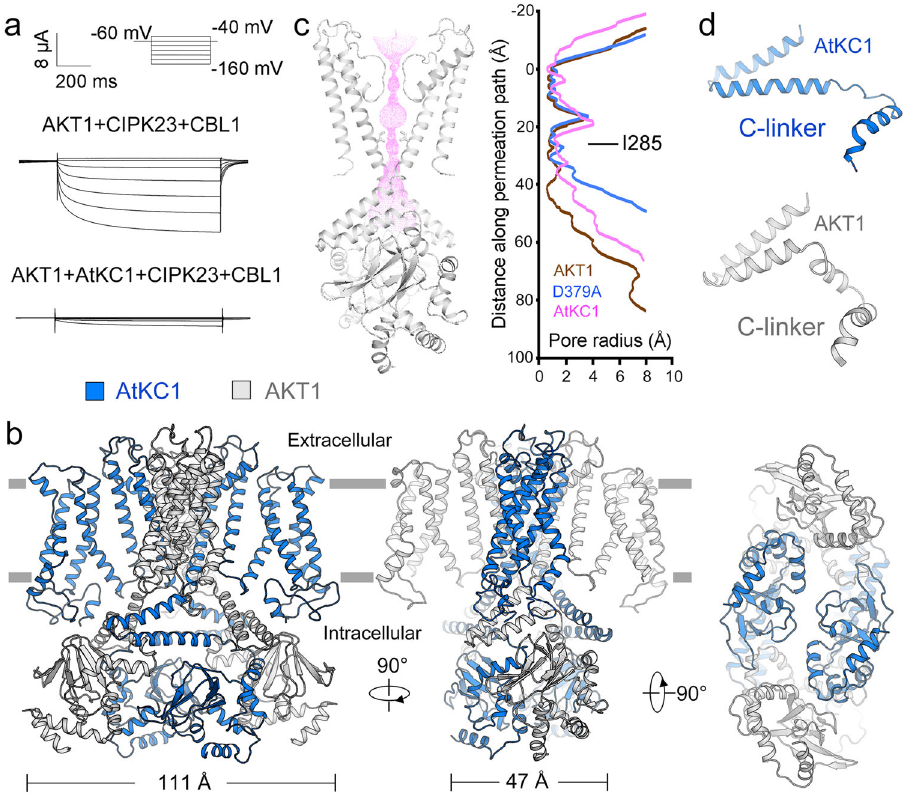
Fig. 6 | Structure of the AKT1-AtKC1 complex displays 2-fold symmetric assembly. a Whole-cell current trace of the AKT1-AtKC1 recorded in Xenopus oocytes.AtKC1negativelyregulatethecurrentsinthepresenceofCIPK23andCBL1. b Structure of the AKT1-AtKC1 in 2-fold symmetry at CPD. c Radius of the pore calculated by the HOLE program 52 . The amino acids restricting the inner gate are